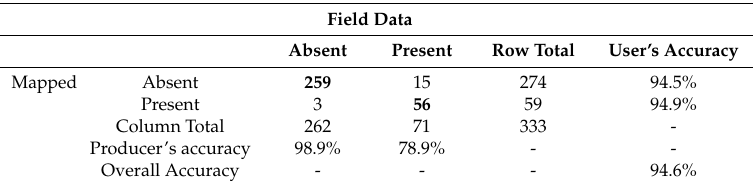
Figure 10. Map of the predicted near-surface permafrost probability calculated by 0.1 m elevation bins for the entire 2009 LiDAR swath. The insets show more detail in areas of relative high elevation ( left ) and areas of relative low elevation ( right ). Transitions between the mudflat and active floodplain deposit (i), and active and inactive floodplain deposits (ii) are also shown. Table 3. LiDAR model accuracy based upon 333 GPS points taken in the field for a 0.9 predicted probability threshold.